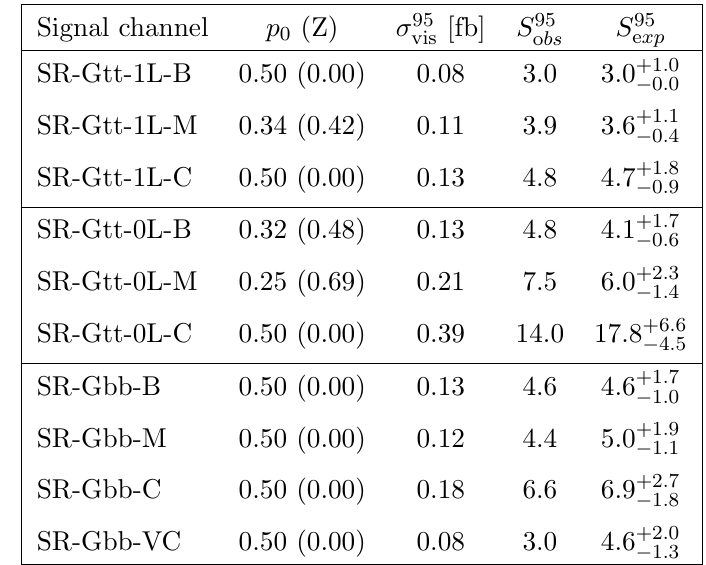
Table 8. The p 0 -values and Z (the number of equivalent Gaussian standard deviations), the 95% CL upper limits on the visible cross-section ( (cid:27) 95 ), and the observed and expected 95% CL upper vis limits on the number of BSM events ( S 95 and S 95 ). The maximum allowed p 0 -value is truncated e xp o bs at